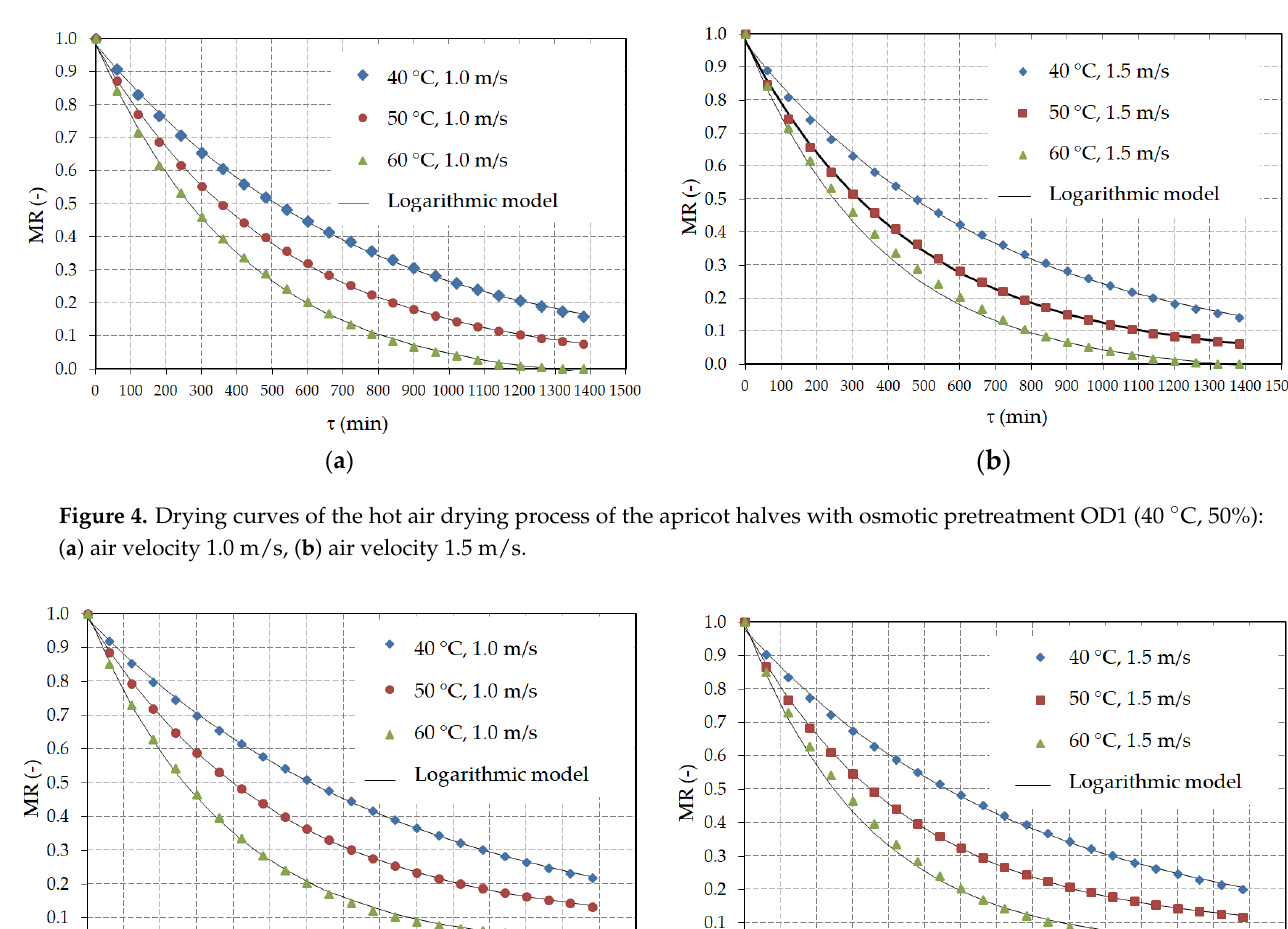
Figure 4. Drying curves of the hot air drying process of the apricot halves with osmotic pretreatment OD1 (40 °C, 50%): ( a ) air velocity 1.0 m/s, ( b ) air velocity 1.5 m/s.